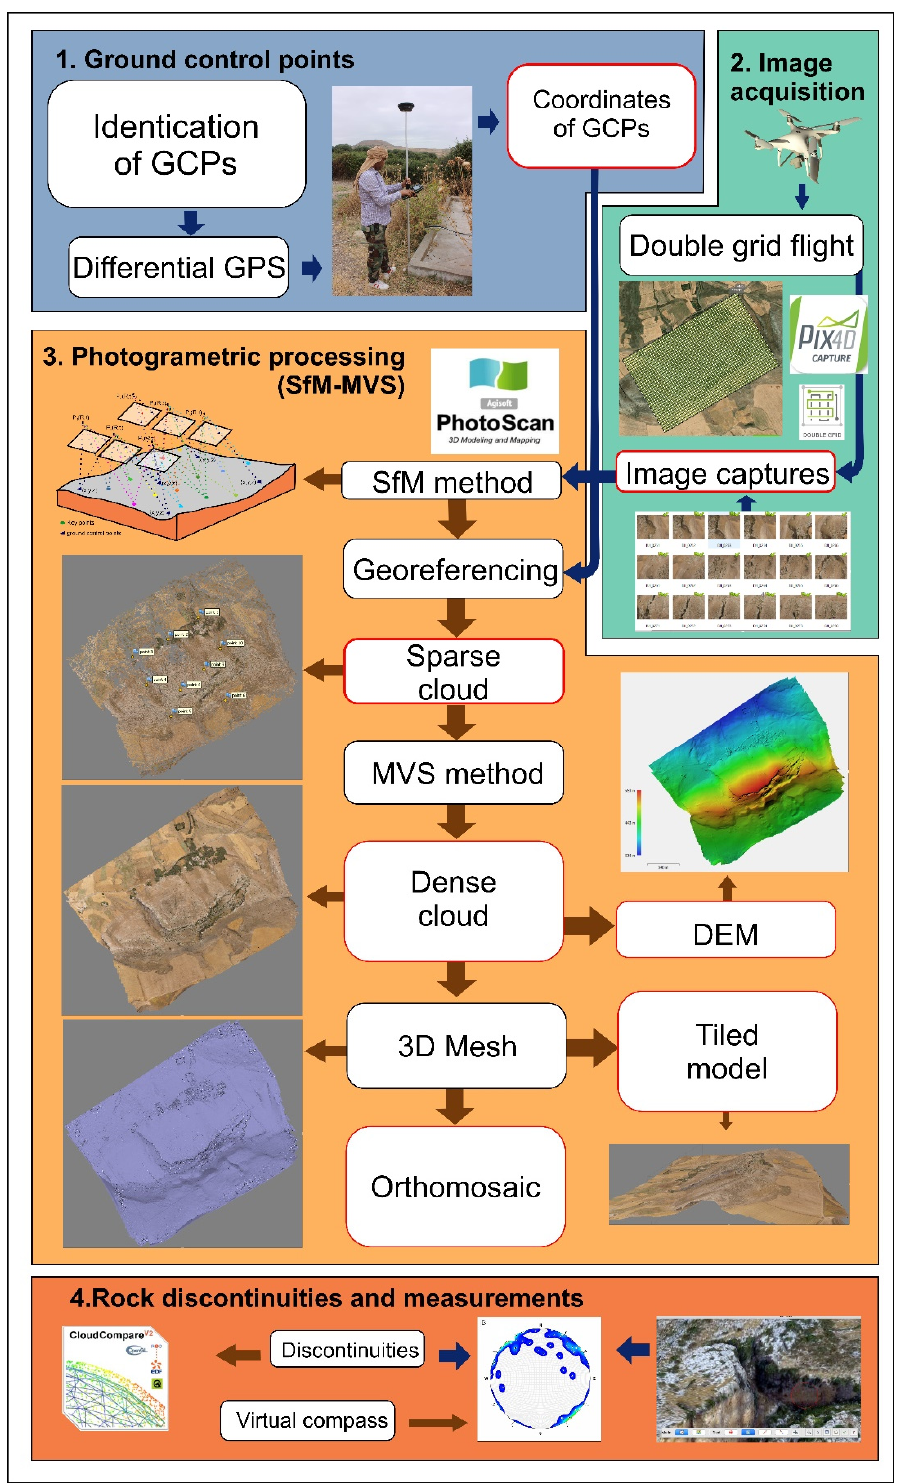
Figure 6. Flow diagram of the UAV survey, 3D model production, and discontinuity investigations.